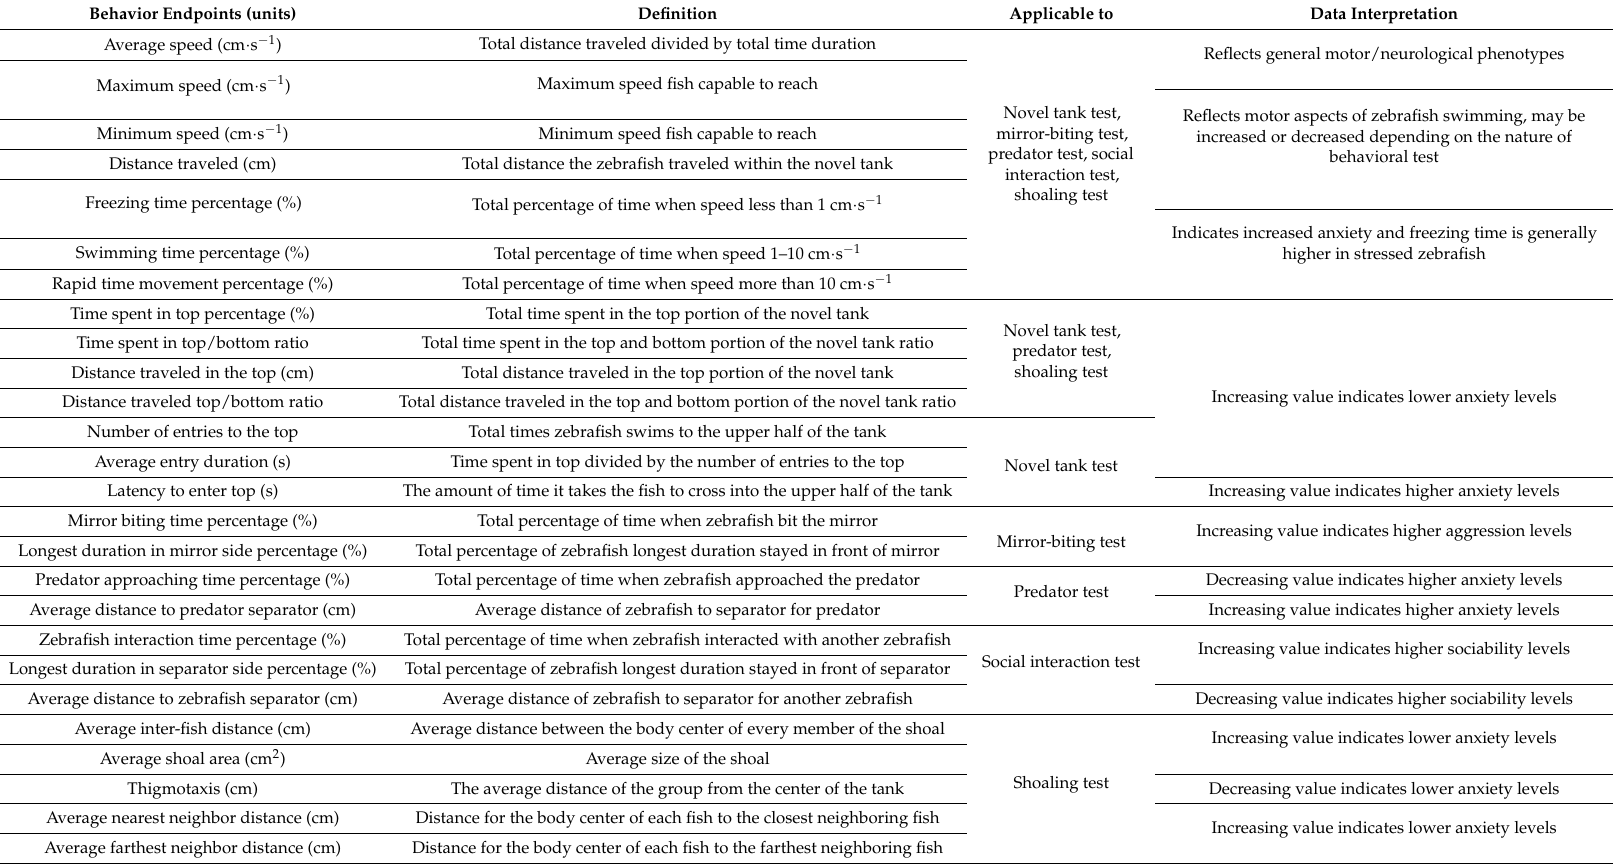
Table 1. Summary of behavior endpoints that can be measured by using zebrafish